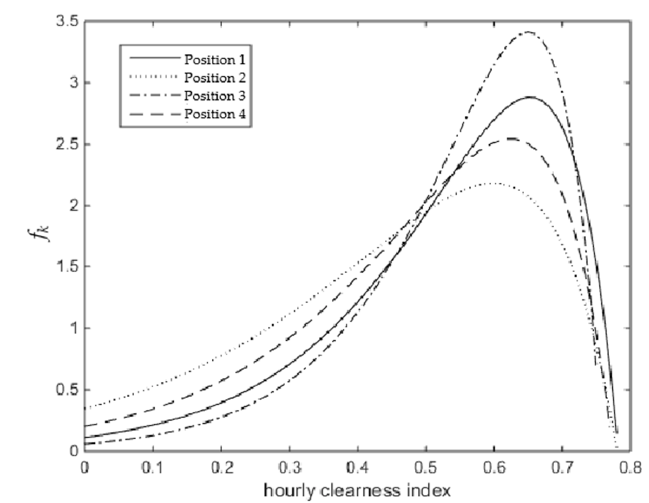
Energies 2020 , 13 , x FOR PEER REVIEW Figure 7. The PDFs of the hourly clearness index in Positions 1–4. Figure 7. The PDFs of the hourly clearness index in Positions 1–4.